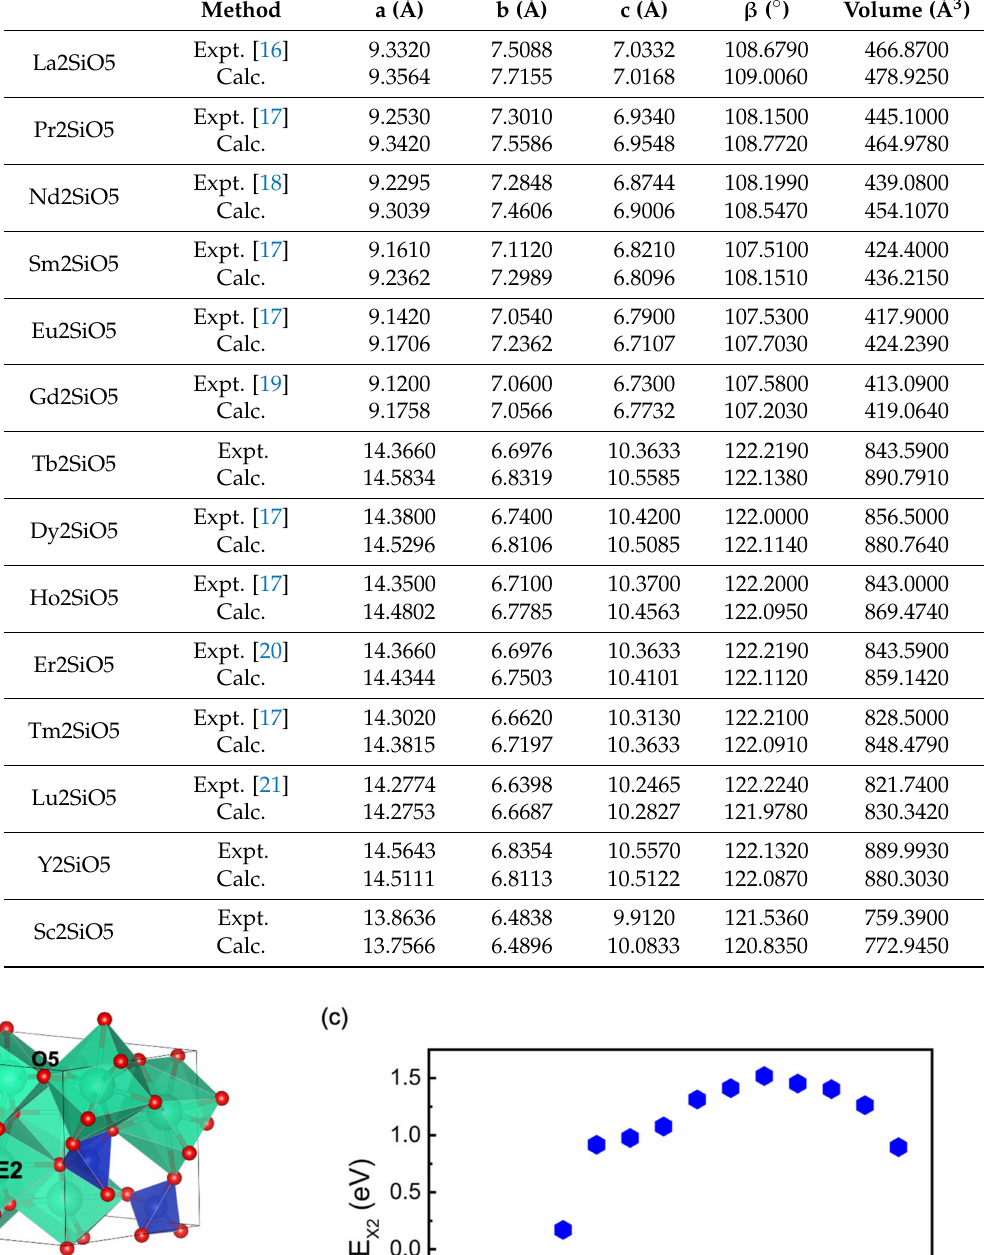
Table 1. Experimental and calculated lattice parameters of X1- and X2-RE 2 SiO 5 .